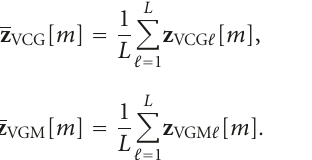
Figure 6: Example of a patient with sinus rhythm: EGM